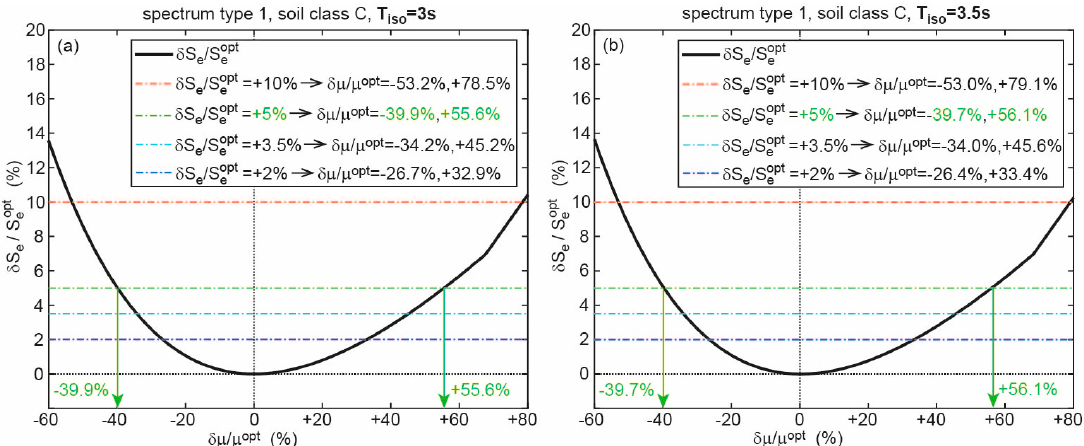
Figure 16. Sensitivity of deviation in friction coefficient from its optimum value on relative increase of structural acceleration for ( a ) T iso = 3 s and ( b ) T iso = 3.5 s and spectrum of type 1 with soil class C.